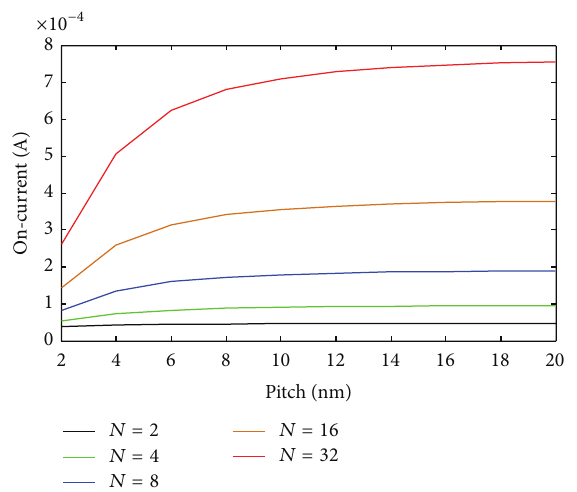
Figure 11: On-current versus pitch for different number of carbon nanotubes.